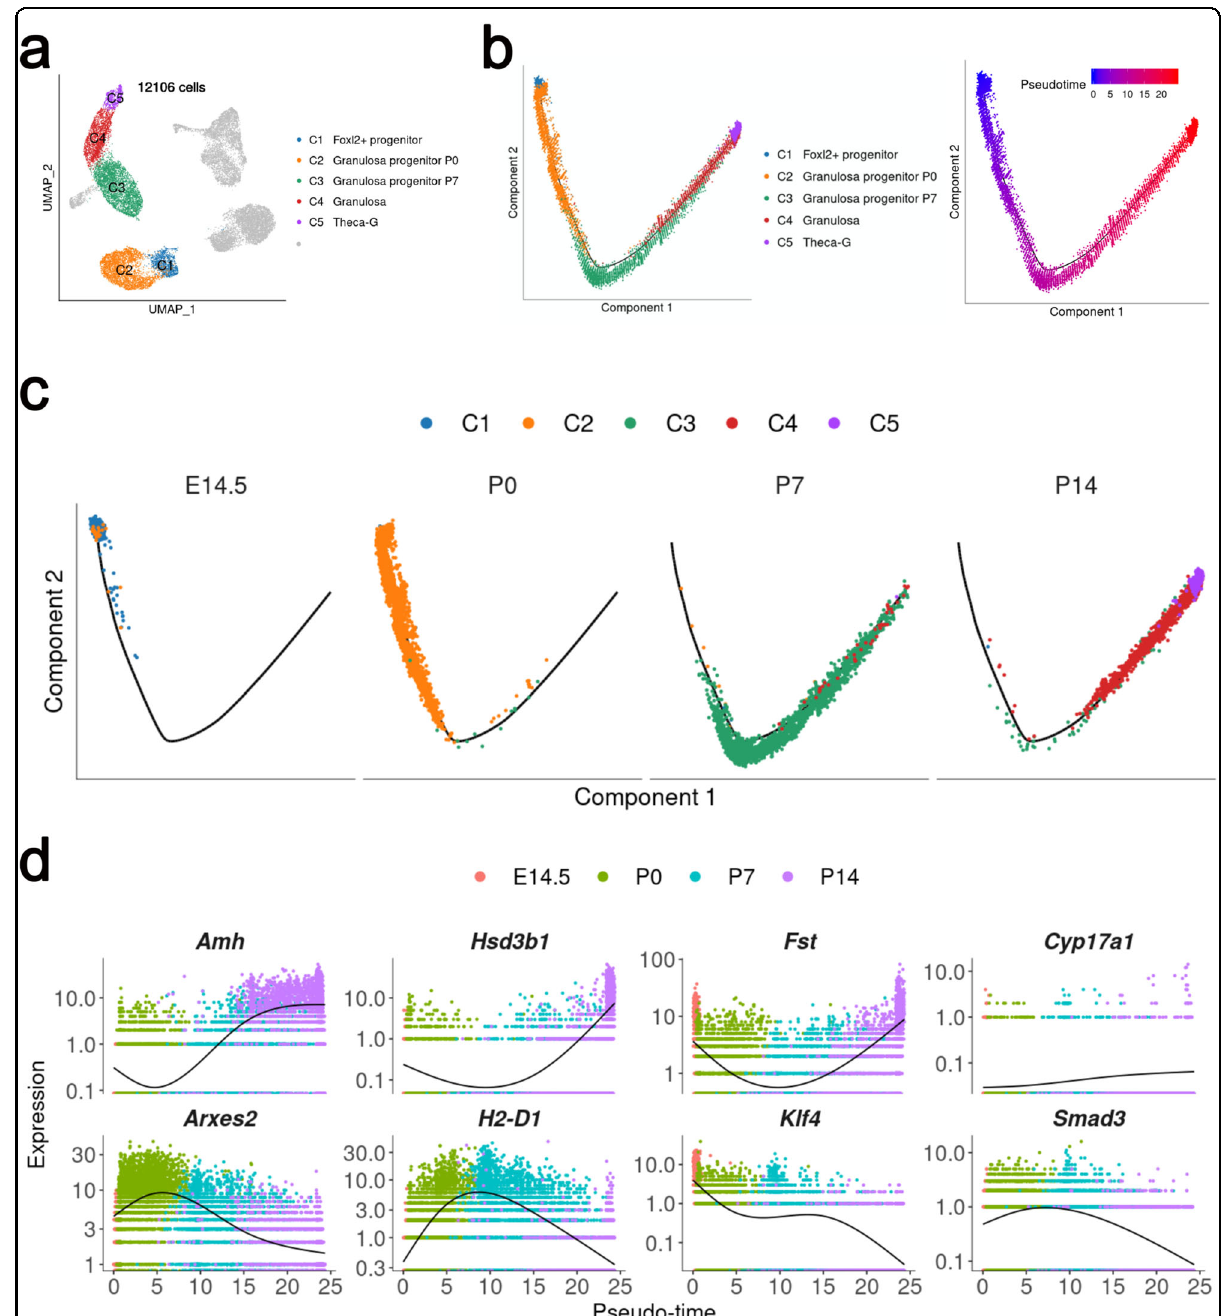
Fig. 5 Cell lineage and pseudotime prediction of divergence of granulosa and Theca-G lineages from a common progenitor population. a UMAP plot as shown in 3a , only the granulosa cell lineage (C1 – C5, 12,106 cells) was used for the following pseudotime analysis. b Pseudotime ordering of cells shown in a , with cells colored by cell clusters (left) and pseudotime (right). The color of pseudotime from blue to red, represented the cell states from naïve to mature. c Pseudotime trajectory plot from b (left) was split by sampling time points, with cells colored by indicated cell clusters. d Pseudotemporal kinetics plots showed the highly expressed genes in granulosa and Theca-G